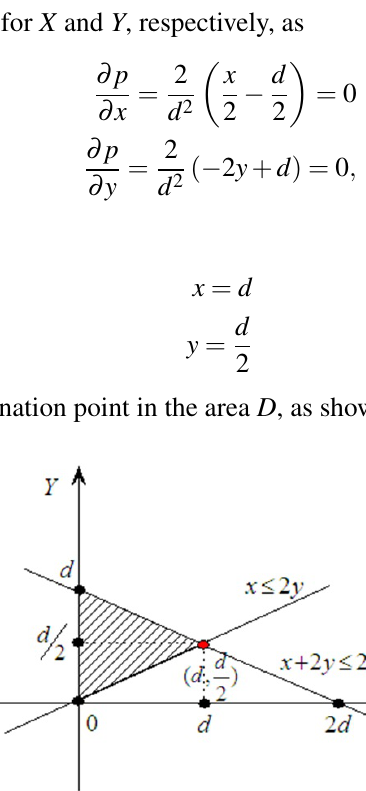
Fig. 9 Schematic diagram of the selection of random probability extreme points and when y = d 0 ≤ x ≤ d , so 0 ≤ p ∗ ≤ 1